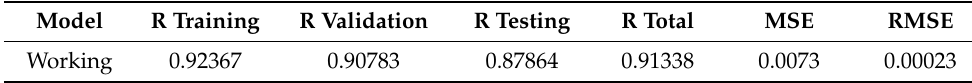
Figure 8. ( a ) Error distribution for the working model; ( b ) Relationship between target and output values for the working model. Table 4. Results of the working ANN model.